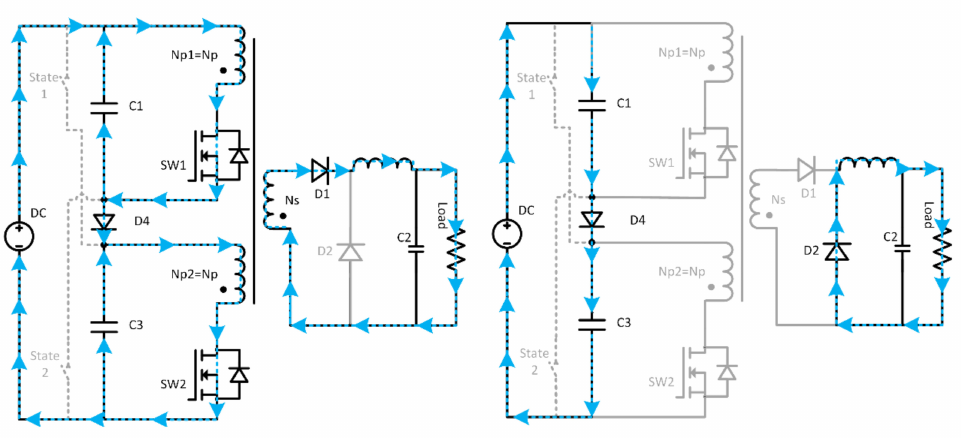
Figure 4. DVFW current loop at high line during ( left ) primary ON time and ( right ) OFF time.